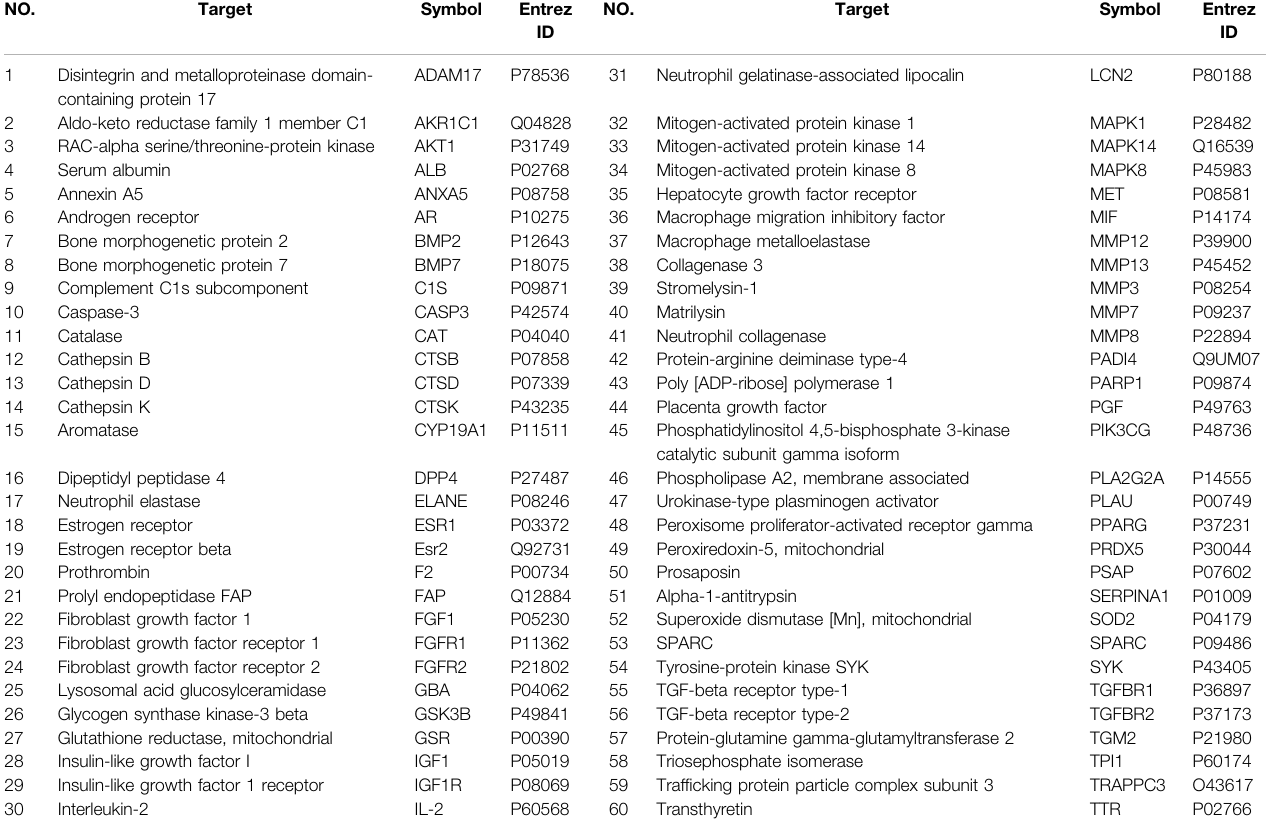
TABLE 2 | The detailed entrez IDs of 60 potential targets of CX anti-OA.